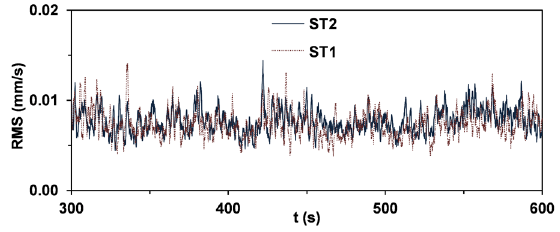
Figure 21. PSDs at Valadier’s buttress in radial direction.